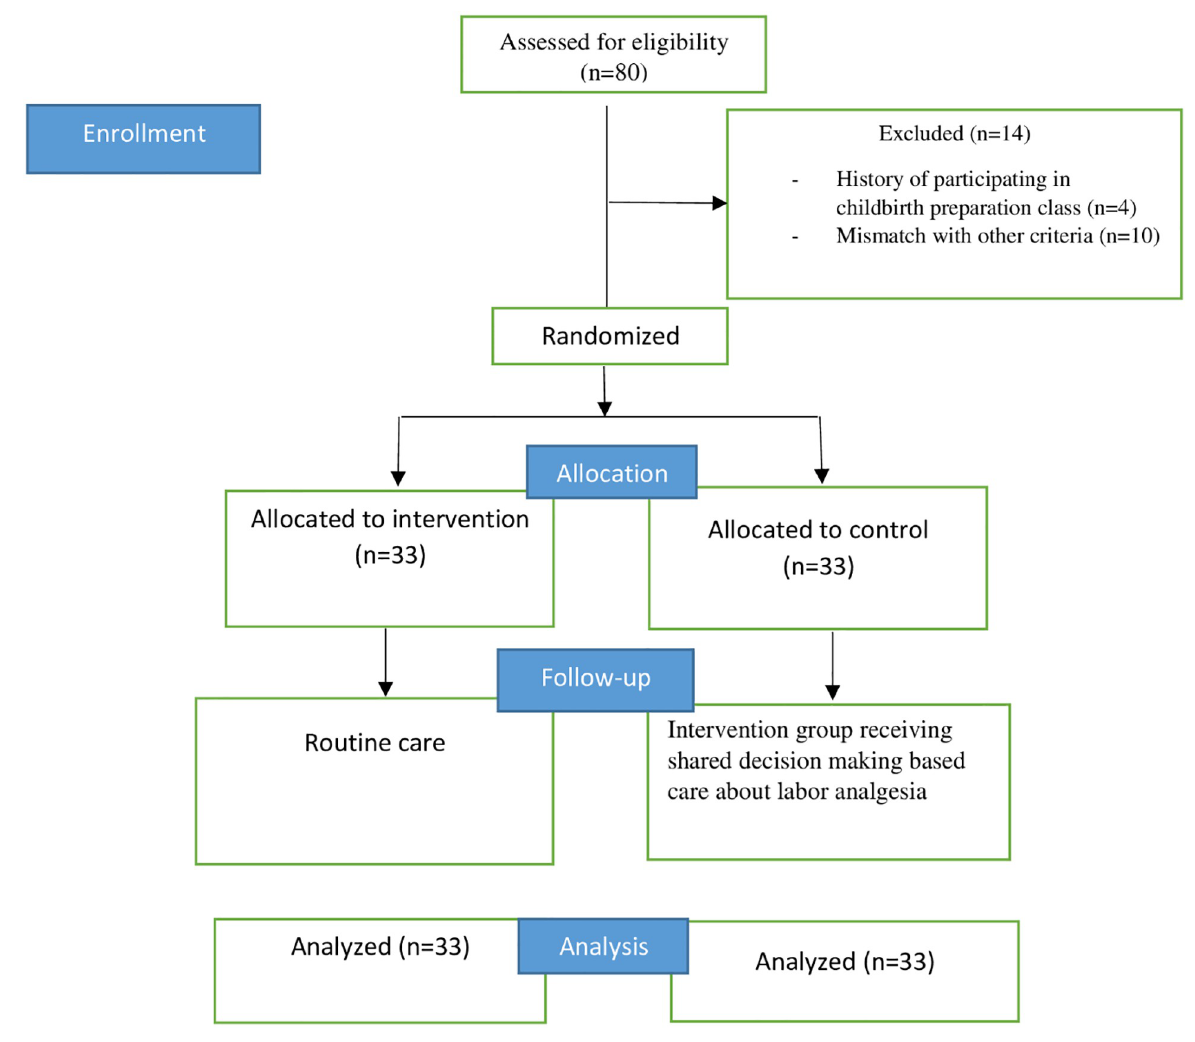
Fig 1. Flow chart of the